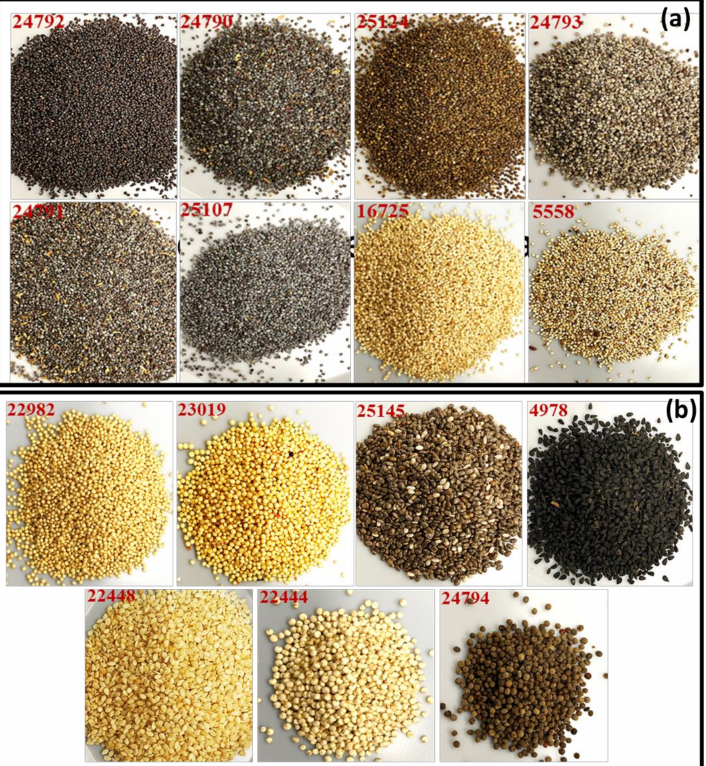
Figure 1. Representative images with NCNPR # of ( a ) poppy seed samples and ( b ) adulterants used in this study.